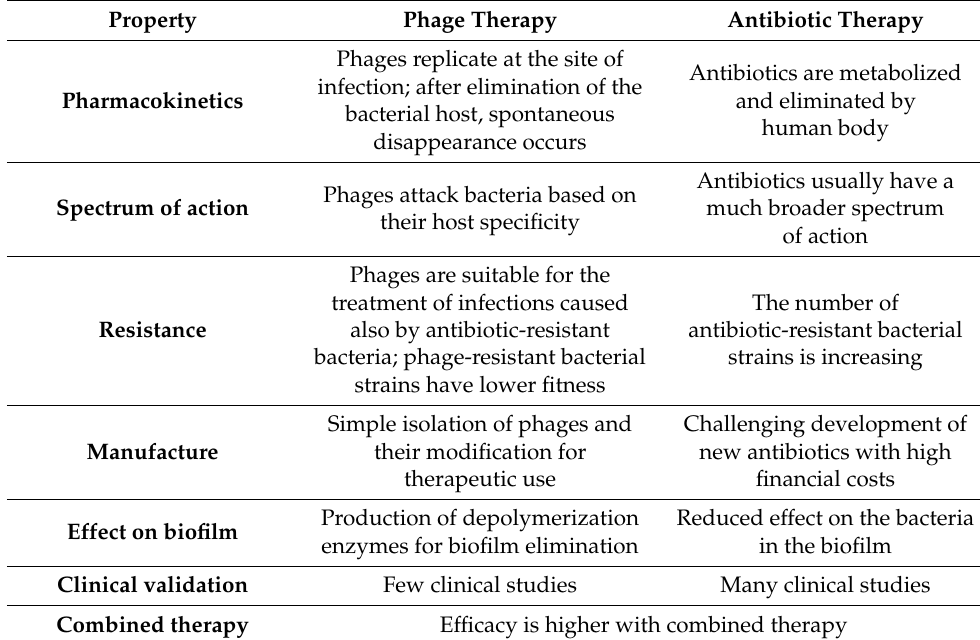
Table 1. Comparison of aspects of phage and antibiotic therapies